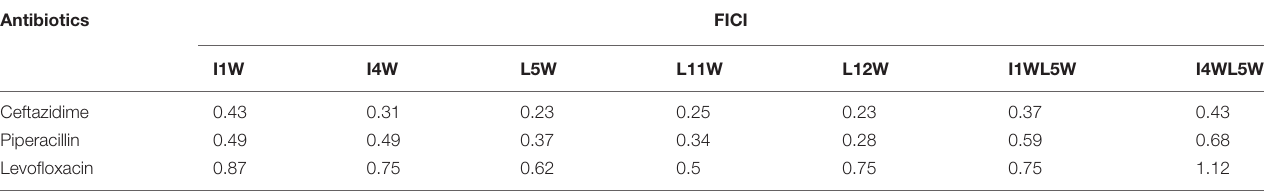
TABLE 1 | The fractional inhibitory concentration index (FICI) of the Trp-containing peptides in combination with antibiotics against MRPA0108. Antibiotics